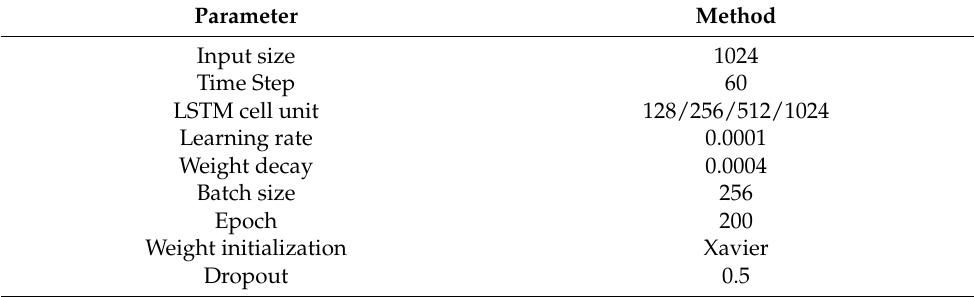
Table 6. Training Parameters of LSTM [26].